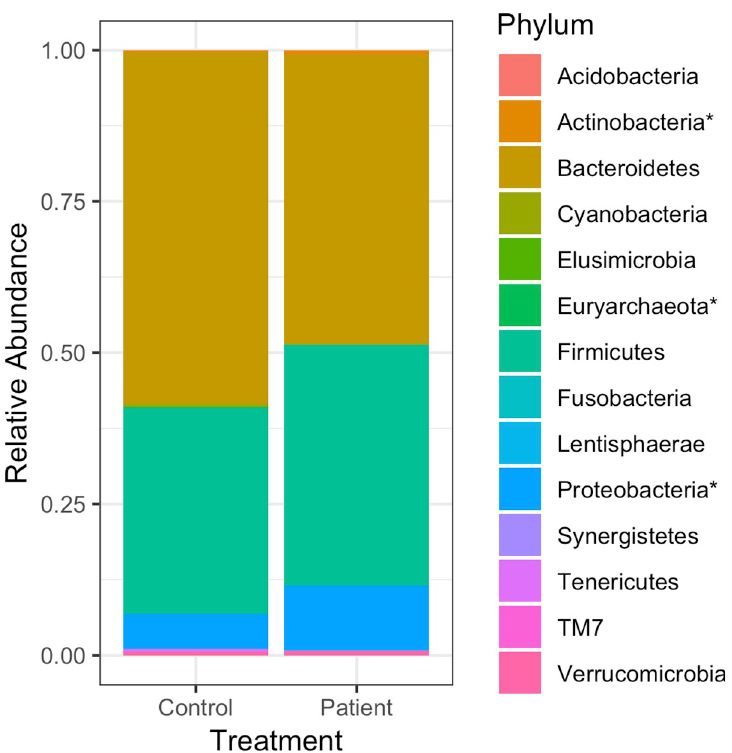
Fig 3. The average relative abundance of phyla found in GSD patients and healthy controls. Phyla followed by an asterisk ( � ) are different, both in terms of statistics and biological consistency, between patients and controls at p